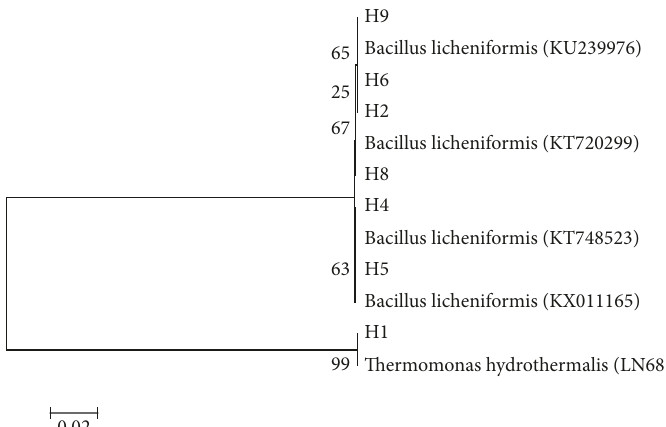
Figure 3: Phylogenetic tree based on total 16S rDNA sequencing (software MEGA 6.0).